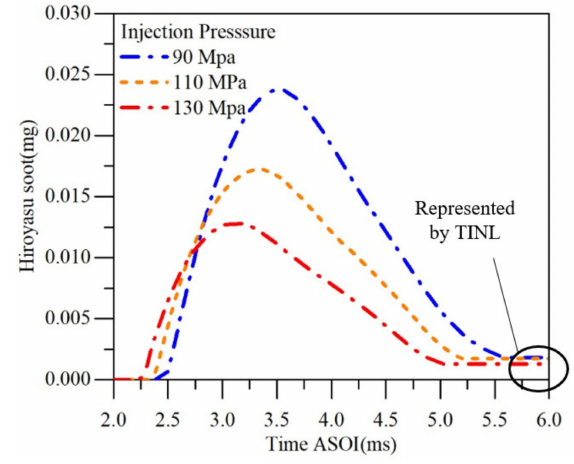
Figure 18. Hiroyasu soot generation in simulation.